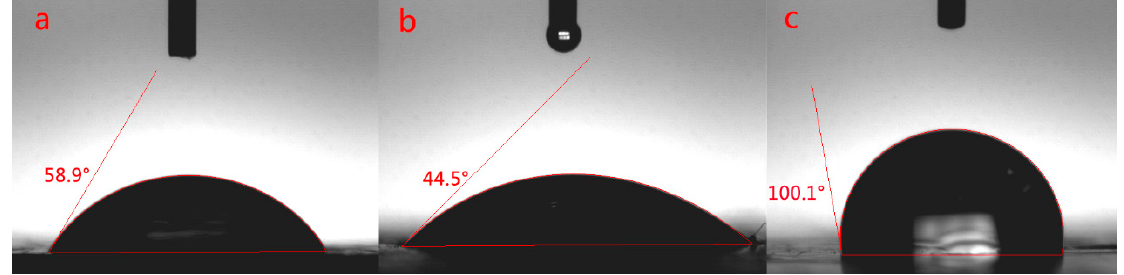
Figure 3. Contact angle test of EP-POSS film modified by nanoparticles. ( a ) EP-POSS/SiO 2 /graphene, ( b ) EP- POSS/ZnO/graphene, ( c ) EP-POSS/graphene.